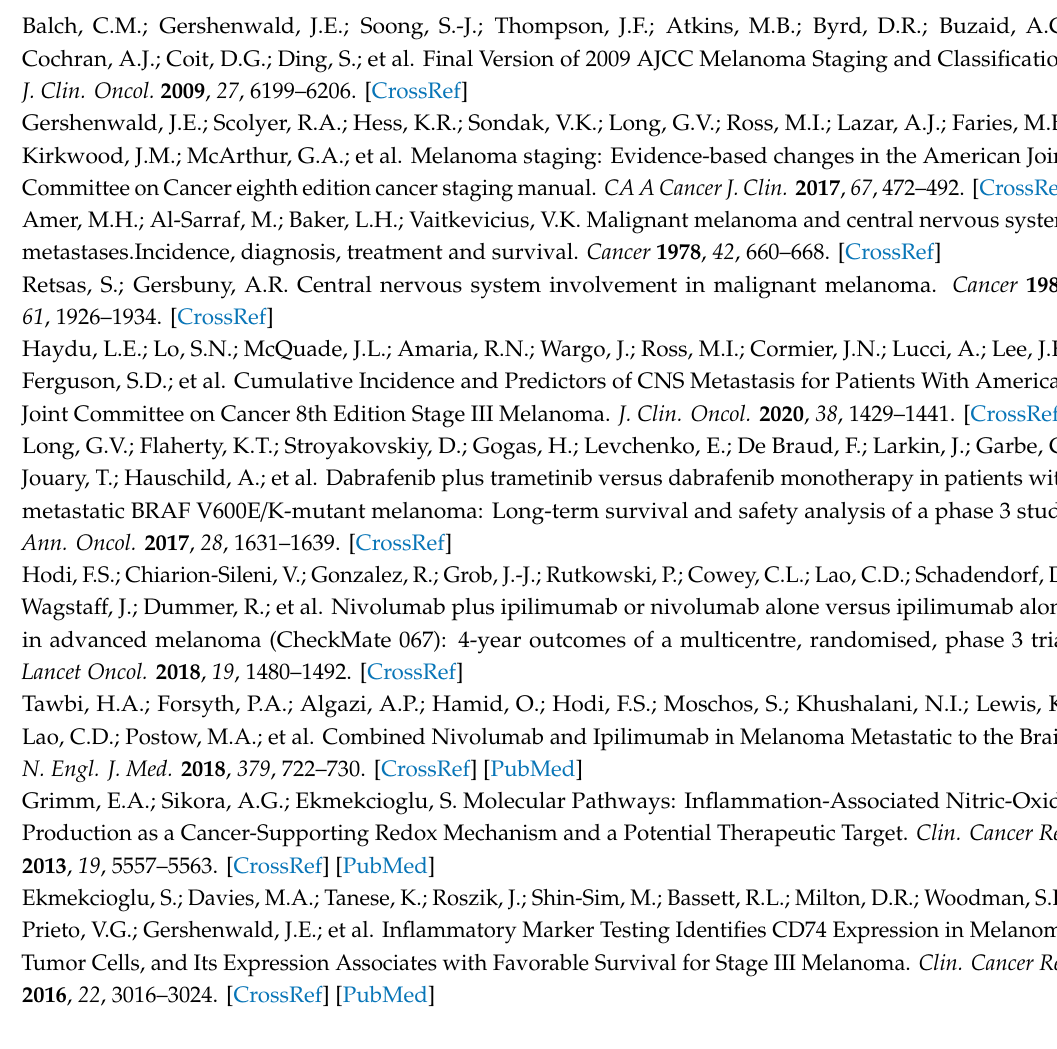
Figure S1: Overall Survival by Individual Markers, Figure S2: Time to CNS metastasis by Individual